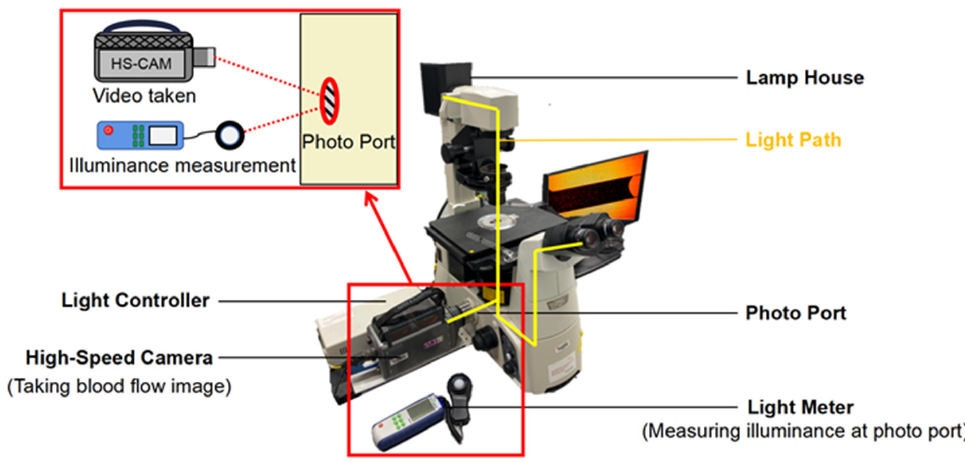
Figure 1. The schematic representation of the experimental setup was used to demonstrate the optical technique for the quantification of hematocrit.